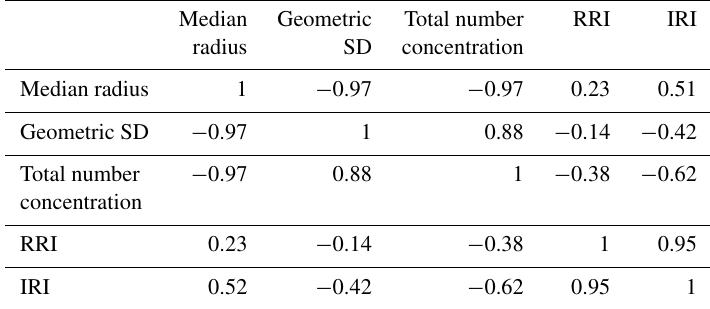
Table 6. Correlation matrix of the retrieved variables for Case 2, assuming the same measurement errors of 5% for backscatter and 20% for extinction and a priori uncertainties listed in Table